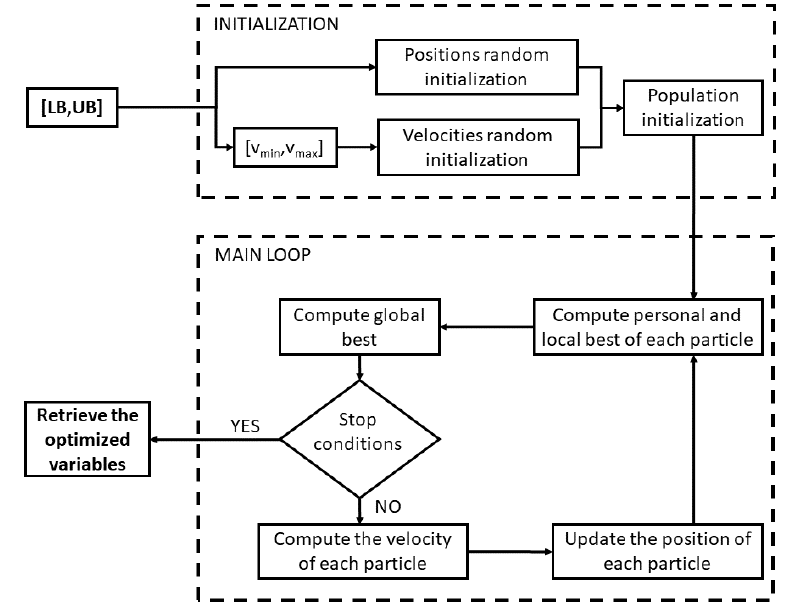
Figure 6. PSO flow